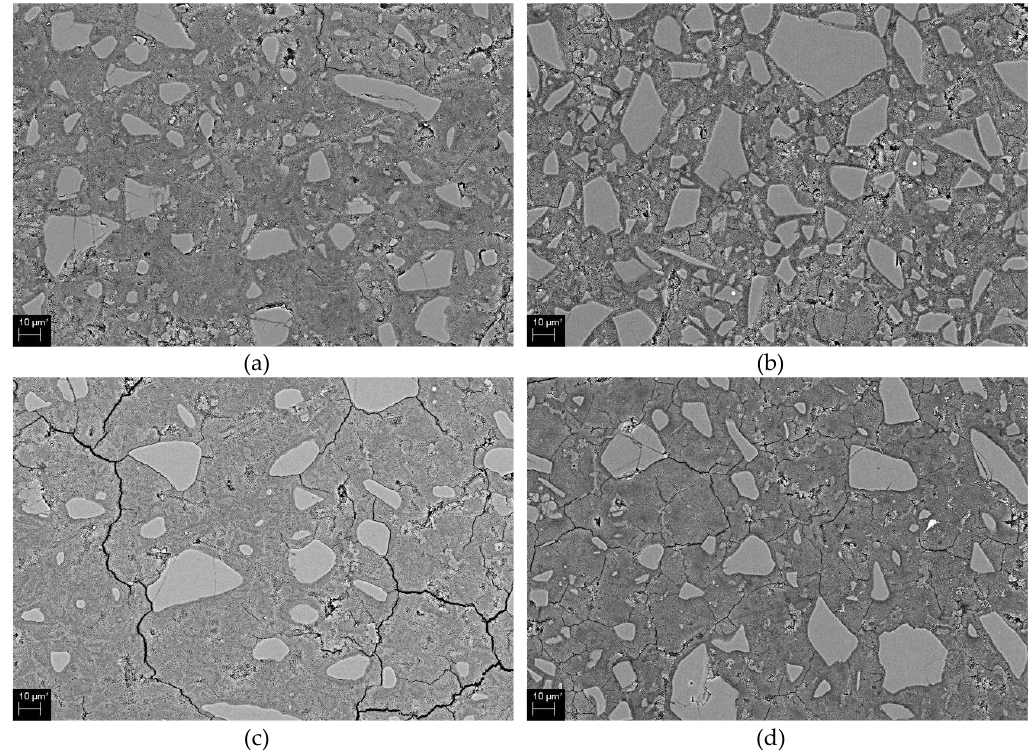
Figure 9. SEM/BSE image showing ( a ) 5% alkali + 0% ALS, ( b ) 5% alkali + 4% ALS, ( c ) 10% alkali + 0% ALS, and ( d ) 10% alkali + 10% ALS.